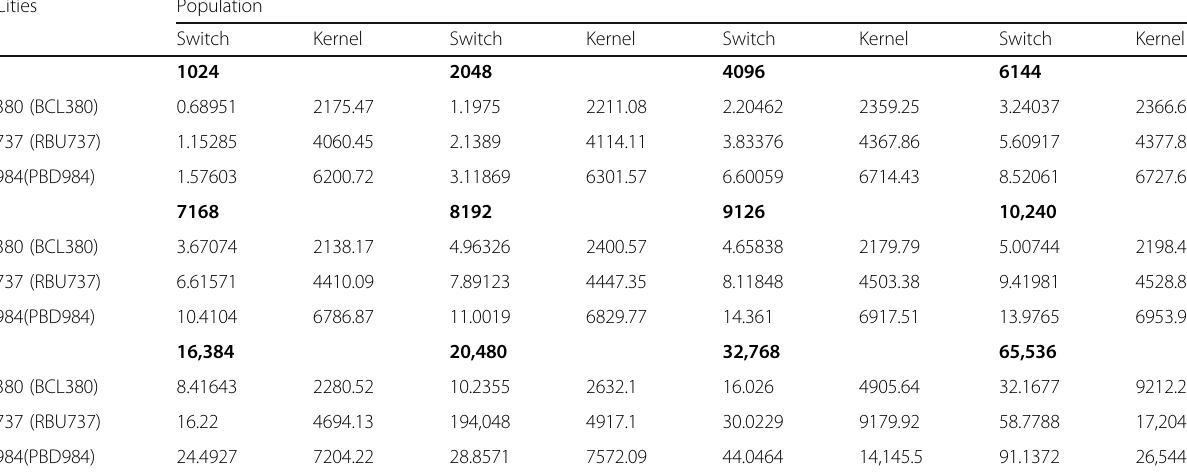
Table 2 Switching and kernel computation time (ms) in CUDA- 100 generations Cities